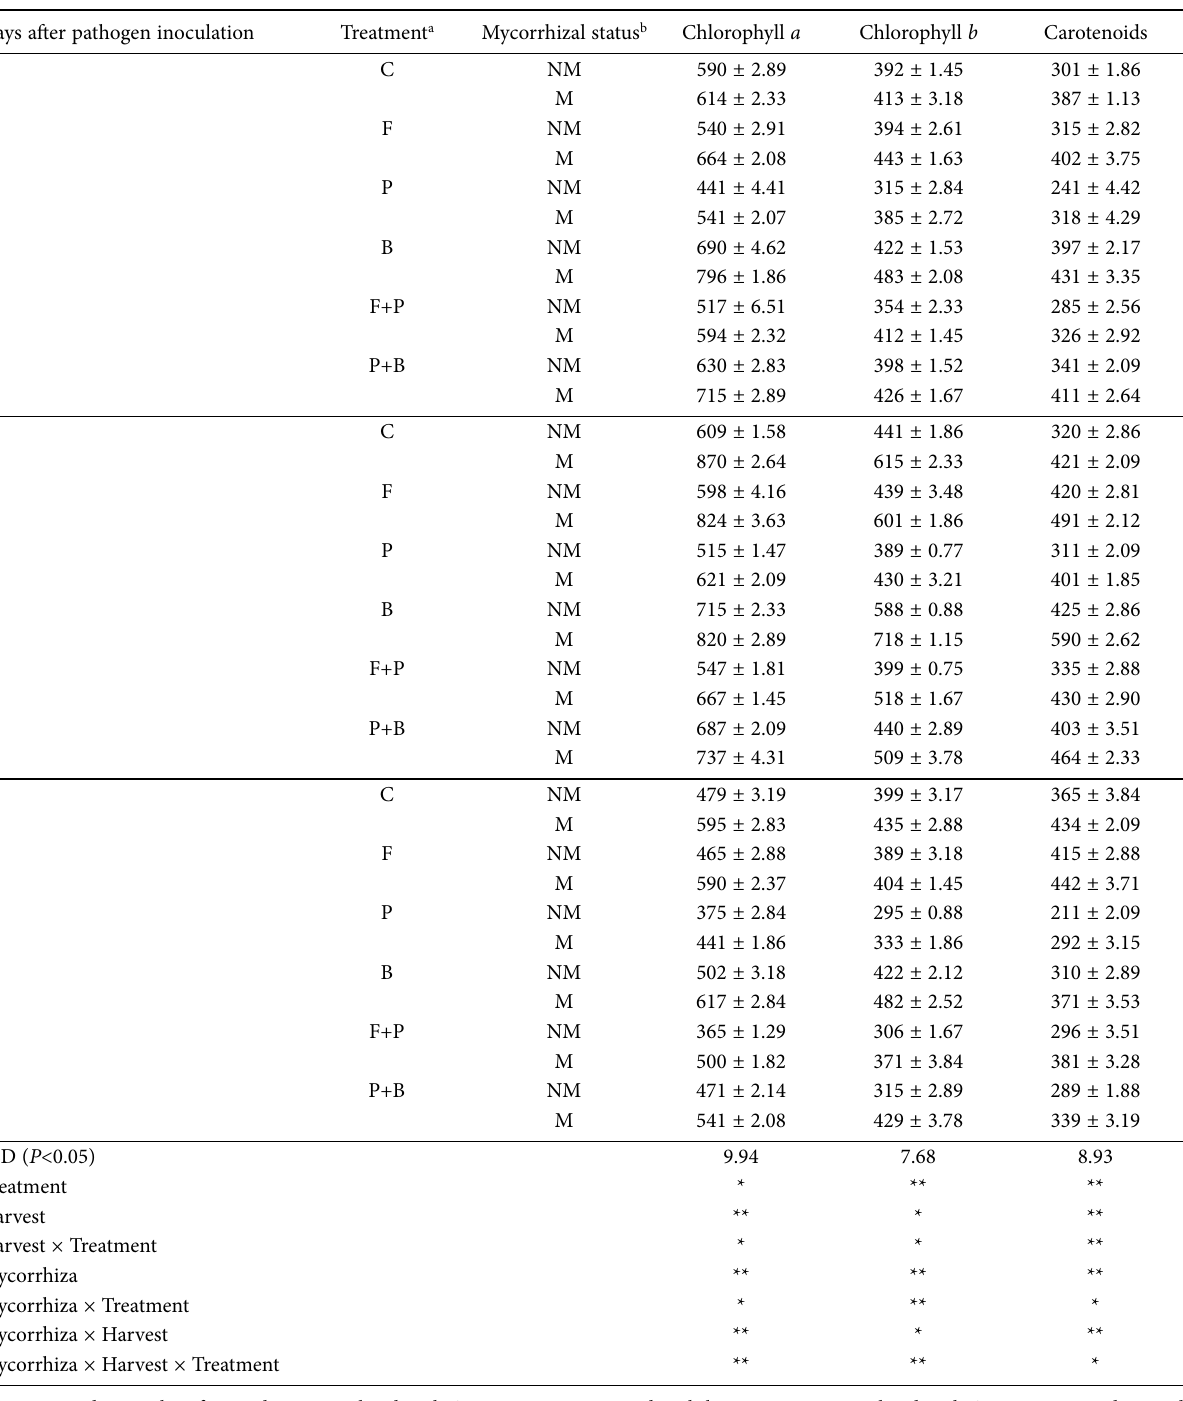
Table 5. Mean concentrations (μg g -1 fresh weight, ± standard error) of photosynthetic pigments in garlic plants at intervals after different Sclerotium cepivorum inoculation and microbial treatments were